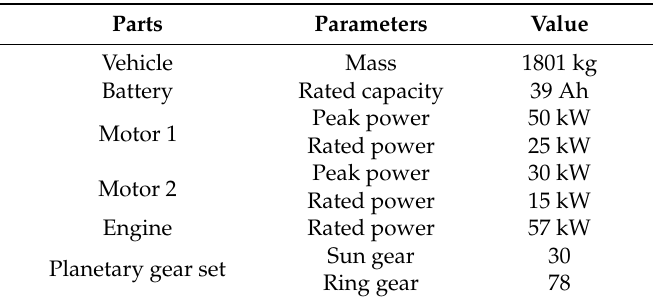
Figure 1. Power-Split plug-in hybrid electric vehicle (PHEV) powertrain structure. Table 1. Main parameters of power-split PHEV.